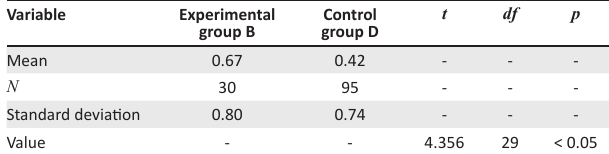
TABLE 5: Making predictions in English – post-test.